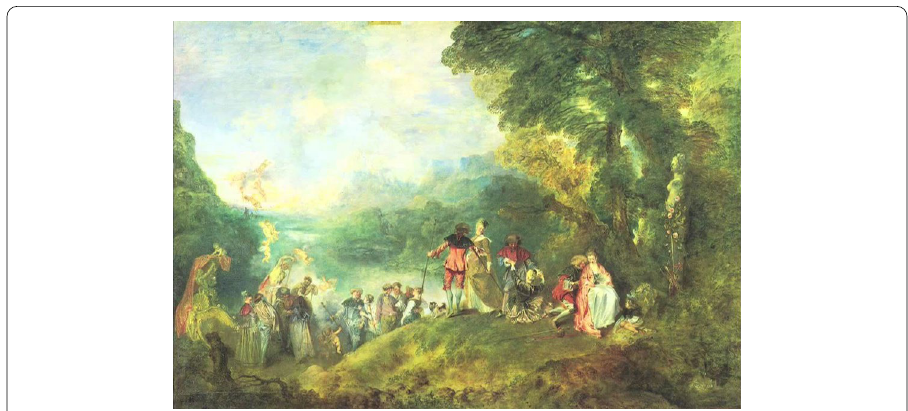
Fig. 2 Embarkation to Cythera (Jean-Antoine Watteau,